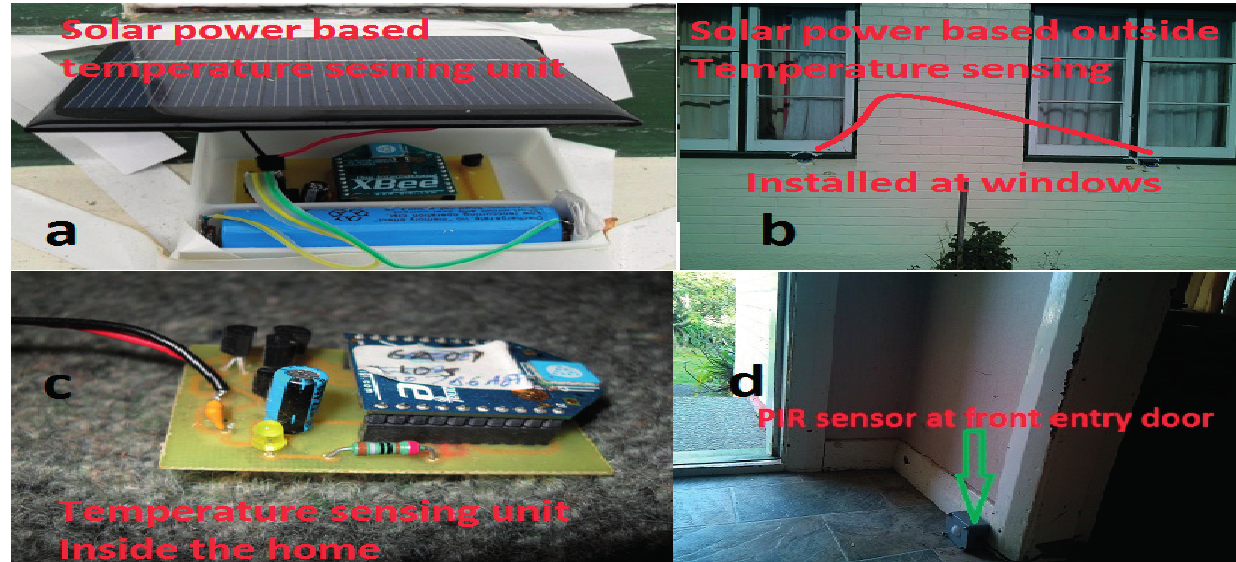
Figure 4. ( a , b ) represent the outside temperature monitoring unit based on renewable solar energy; ( c ) inside temperature monitoring unit and ( d ) PIR sensor for activity monitoring.